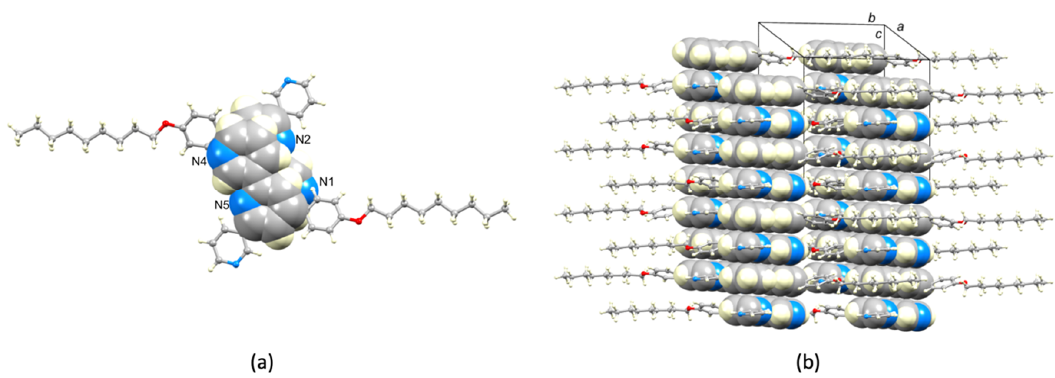
Figure 8. Within each layer of molecules of 8 , van der Waals interactions between n -alkyloxy chains, and C–H...N and C–H...O weak hydrogen bonds (red hashed lines) are important packing interactions. See Figure S15 for a space-filling representation.